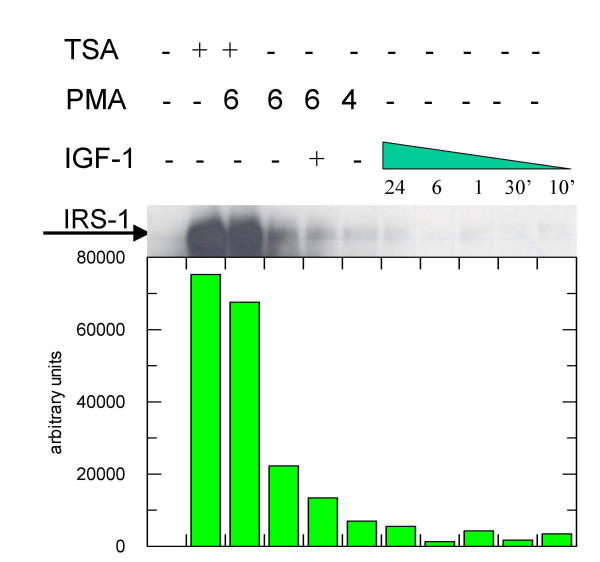
IRS-1 is a lysine acetylated protein. MCF-7 cells were treated with IGF-1 (10 ng/ml) for the indicated times, PMA (10 ng/ml) for 4 or 6 hours as indicated or TSA (150 ng/ml) for 4 hours prior to lysis and immunoprecipitation of IRS-1 Western blots were probed for the presence of acetyl lysine. Densitometric analysis of acetylated IRS-1 was performed and is displayed in the histogram. This experiment has been repeated one other time although the effects of TSA on acetylation of IRS-1 have been observed in many other experiments.